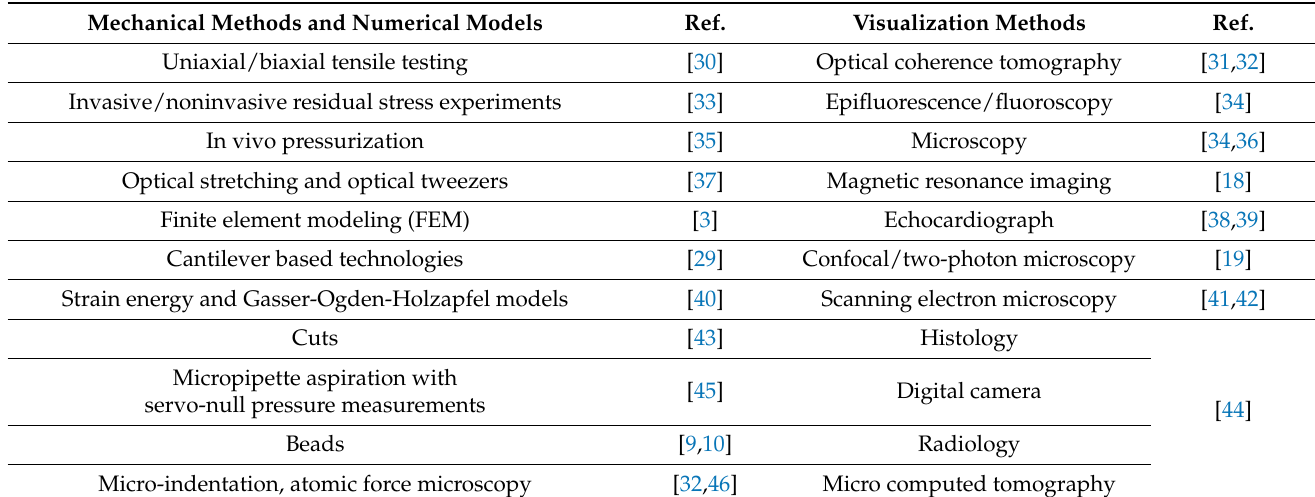
Table 1. Summary of established mechanical techniques used to acquire the embryonic material properties and associated visualization